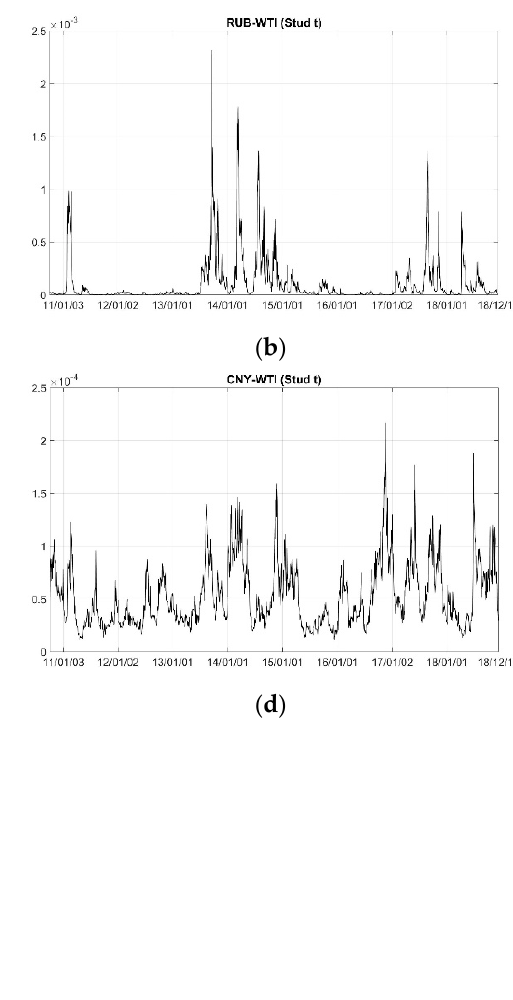
Figure 2. Dynamic parameters from the time-varying copula models. ( a – e ) refer to BRL–WTI, RUB–WTI, INR–WTI, CNY–WTI and ZAR–WTI pairs, respectively.